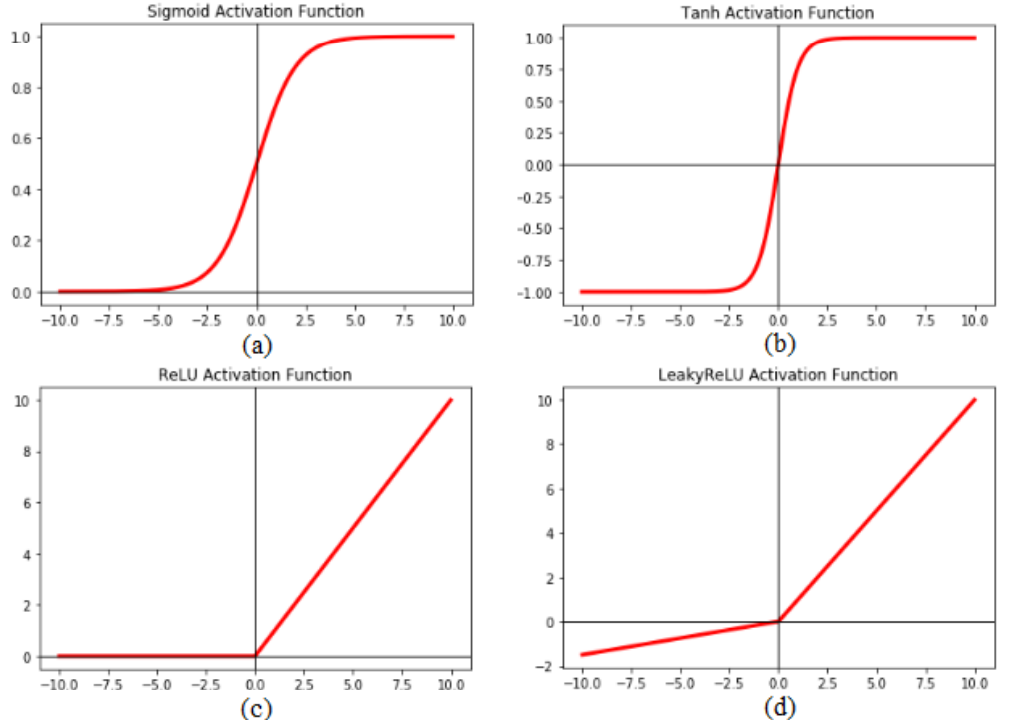
Figure 5. Plot of different activation functions: ( a ) Sigmoid activation function; ( b ) Tanh activation function; ( c ) ReLU activation function; and ( d ) LeakyReLU activation function. The x-axis represents the input x and the y-axis represents the output function f ( x ) .